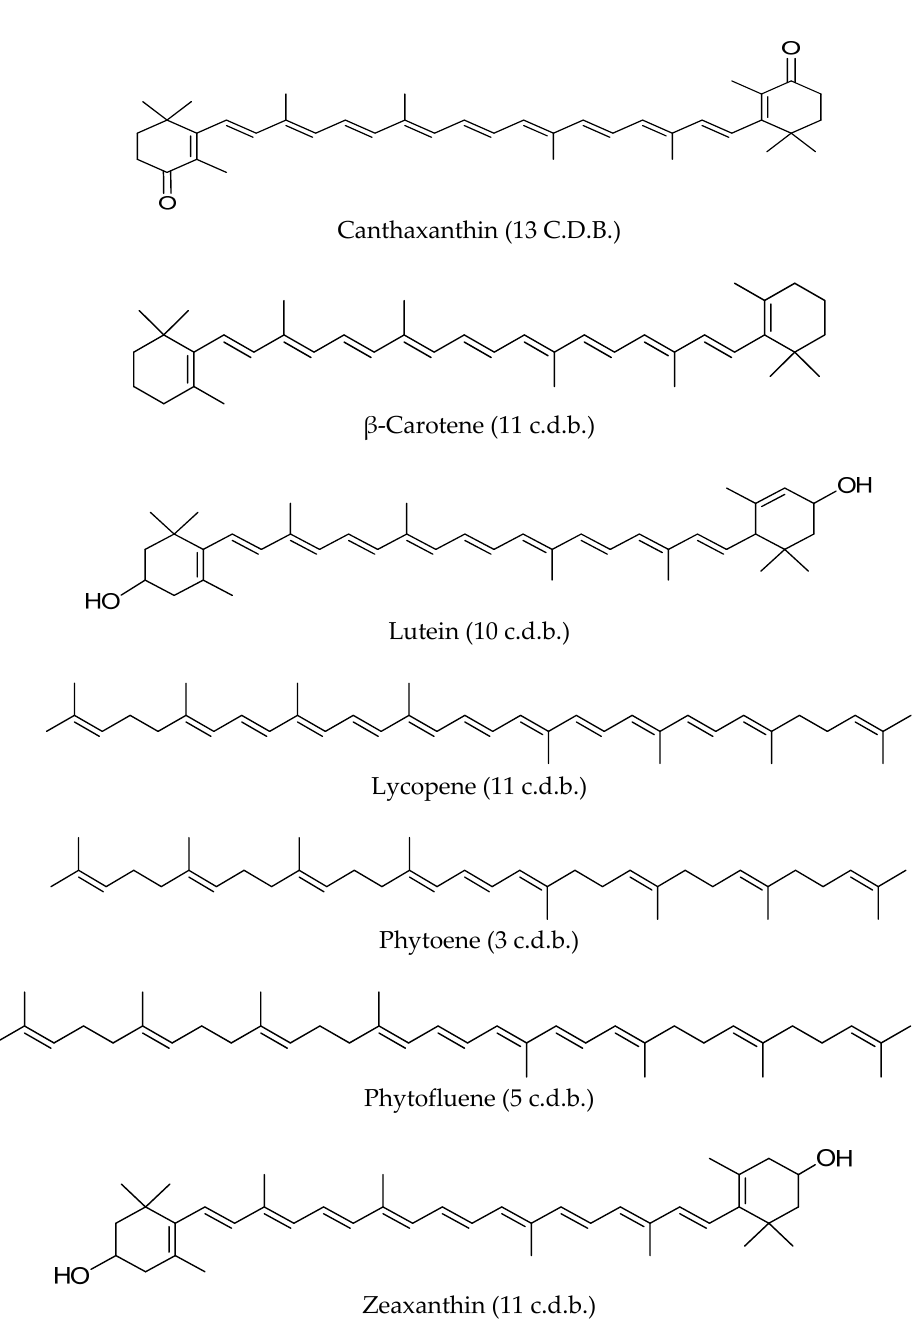
Figure 3. Chemical structures of some carotenoids of interest for skin health and appearance.